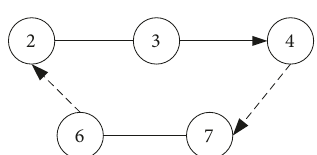
Figure 14: Topological cycle in the